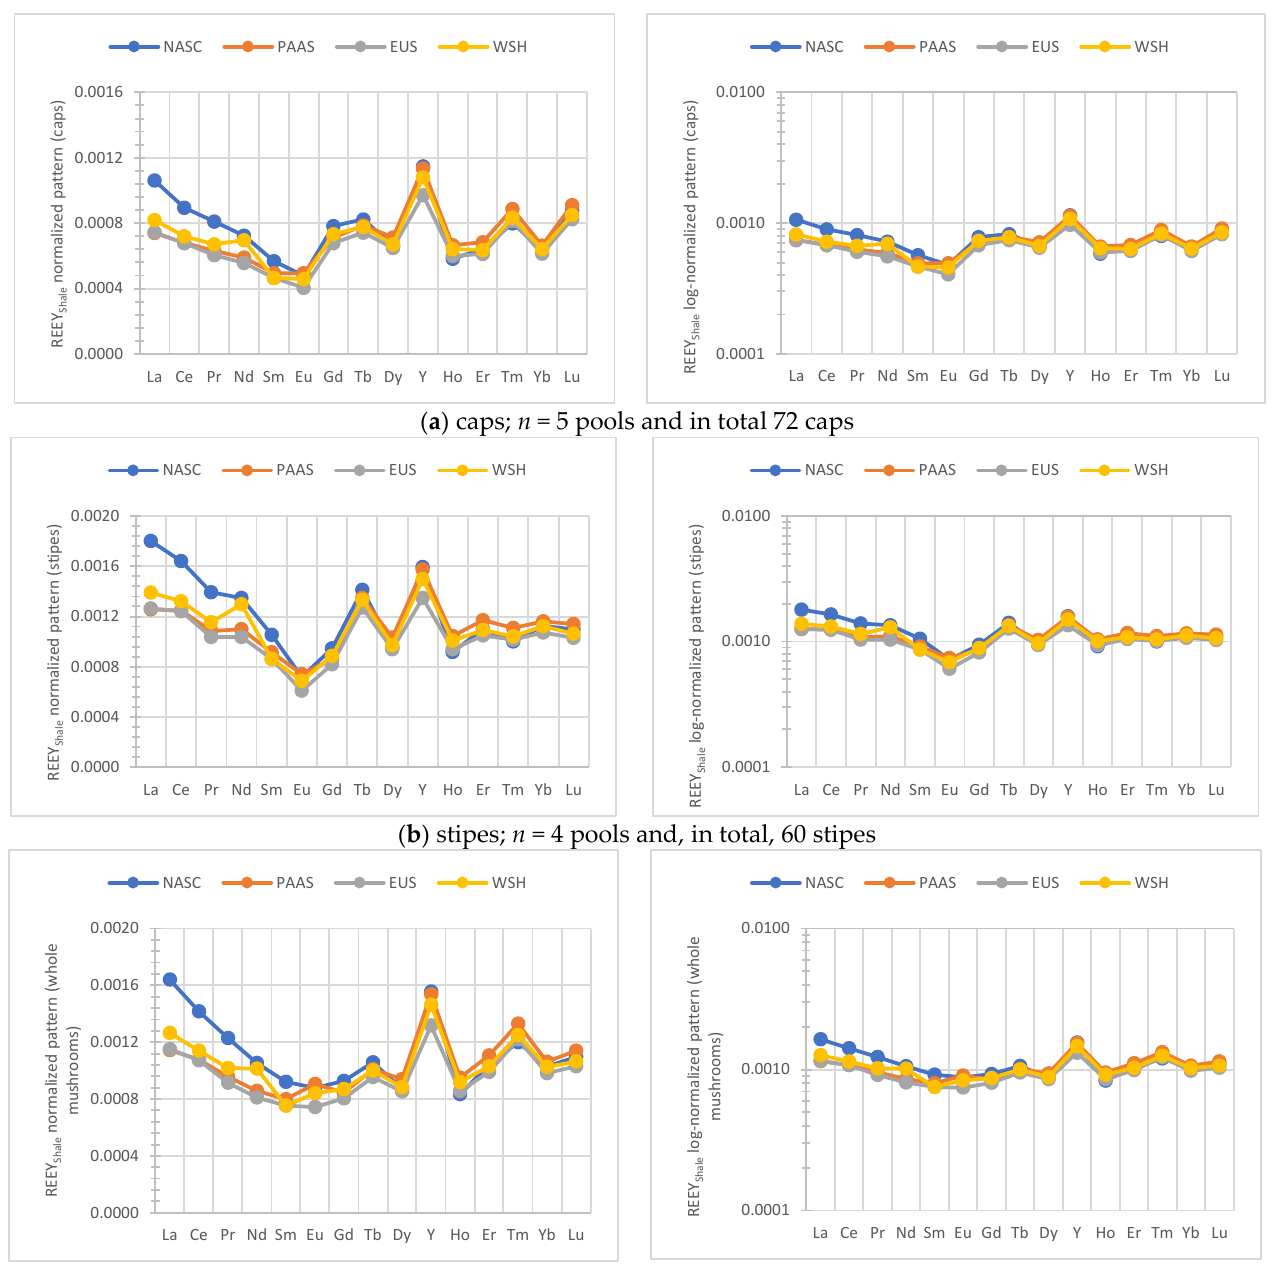
Figure 2. The shale (NASC, PAAS, EUS and WSH) normalized normal and log-normal patterns of REEY in B. edulis (medians for the caps, stipes, and the whole fruiting bodies).